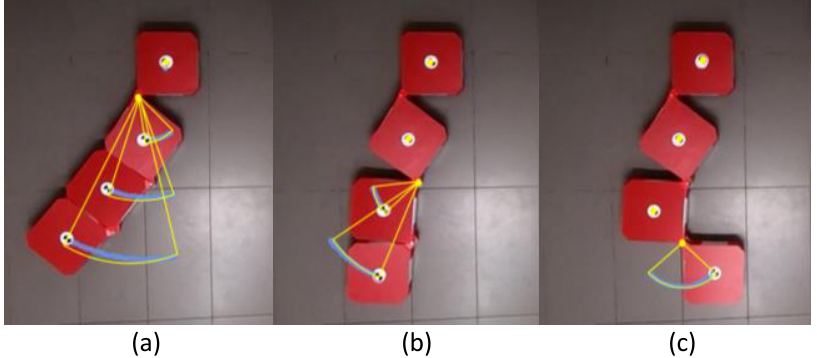
Figure 7. Motion analysis of the reconfiguration. The traced paths are annotated in blue. The expected movement paths are given in yellow. Reconfigurations through hinge 1, 2, and 3 are given in ( a – c ),